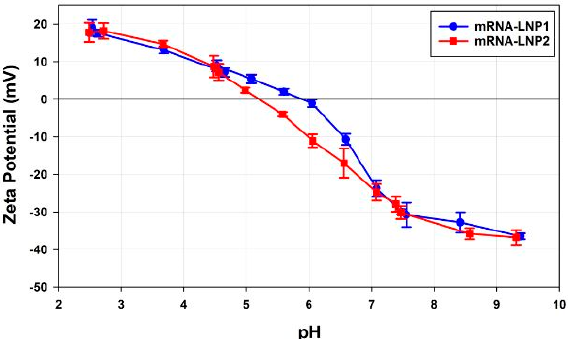
Figure 10. A plot of the zeta potential values (in mV) as a function of pH for mRNA-LNP1 and mRNA-LNP2 samples prepared in 10 mM NaCl.